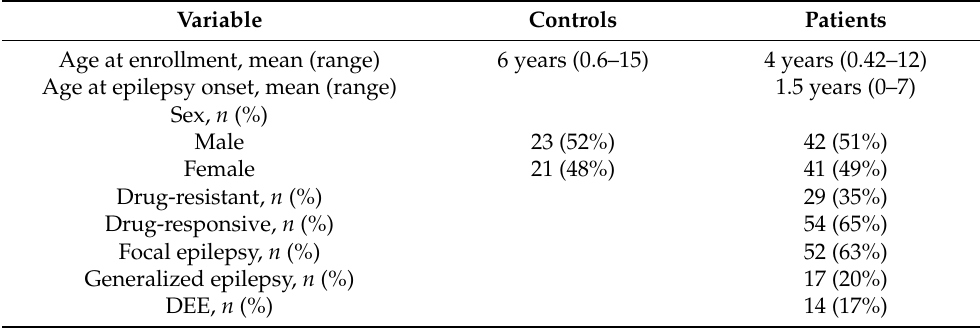
Table 1. Demographic and clinical data of children with epilepsy and control group. Variable Controls Patients Age at enrollment, mean (range)